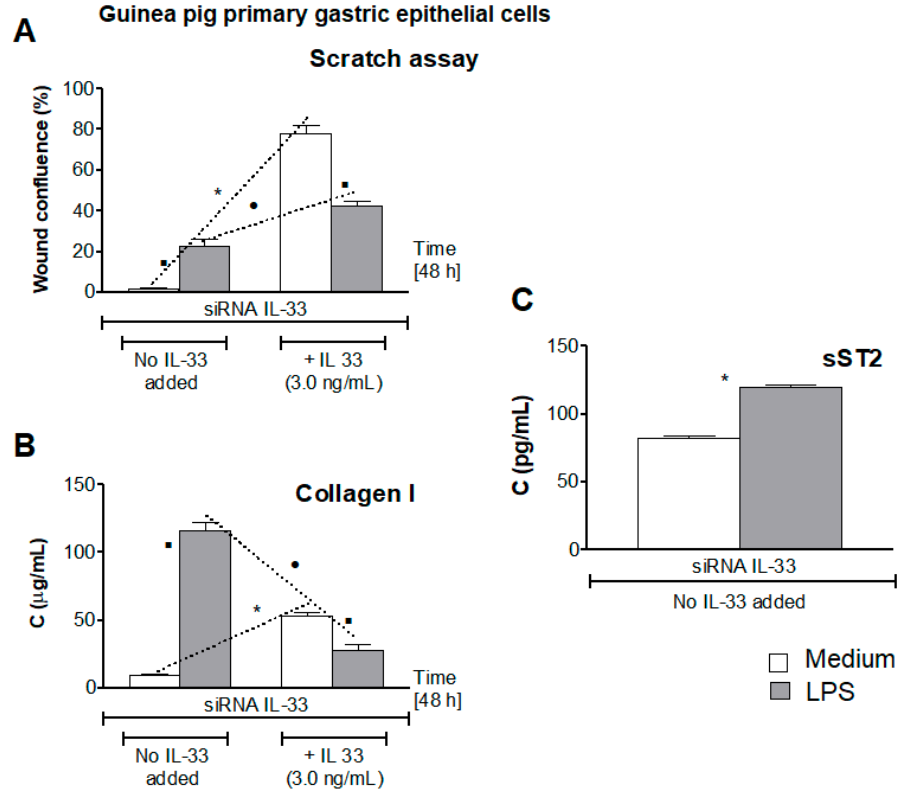
Figure 5. Pro-regenerative activity of gastric epithelial cells. The cells transfected with siRNA IL-33, which were not exposed or exposed to lipopolysaccharide (LPS) H. pylori (25 ng/mL), were sub- cultured in medium without or with IL-33 alone 3.0 ng/mL. Cell monolayers were scratched and then the cells’ ability to migrate was assessed ( A ). Cell culture supernatants were used for assessment of collagen I concentration ( B ) by the enzyme-linked immunosorbent assay (ELISA). Furthermore, the level of soluble ST2 (sST2), was assessed by the ELISA in cell cultures of siRNA IL-33 transfected cells not exposed or exposed to LPS H. pylori ( C ). Results are shown as median with the range of five experiments performed in triplicate for each experimental variant. Statistical analysis was performed using the nonparametric Mann-Whitney U test with significance at p < 0.05. * cells in medium without IL-33 vs. cells in medium with IL-33, not treated with LPS H. pylori ; ● cells treated with LPS H. pylori , in medium without IL-33 vs. cells treated with LPS in medium with IL-33; ▪ cells not treated with LPS H. pylori vs. cells treated with LPS H. pylori , in medium without or with IL-33.